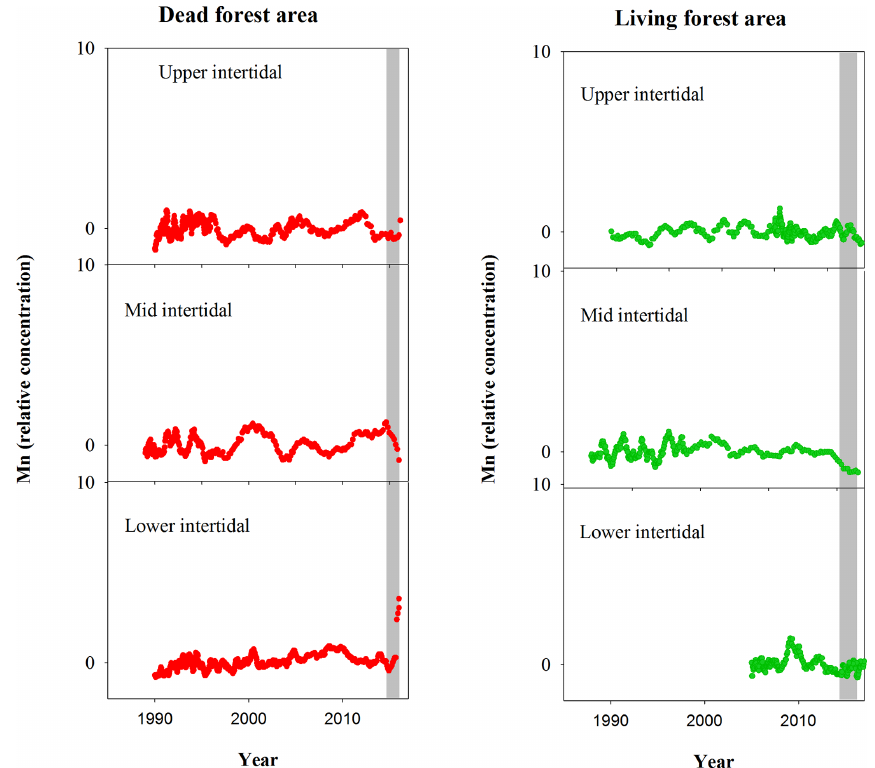
Figure A1. Normalized Mn relative concentrations in mangrove wood over time in living (green dots) and dead (red dots) mangroves from upper, mid and lower intertidal areas of the Gulf of Carpentaria, Australia. Grey areas indicate the dieback